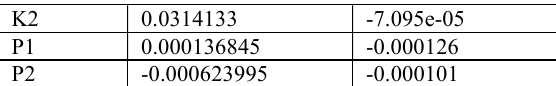
Table 1. The estimated camera calibration values